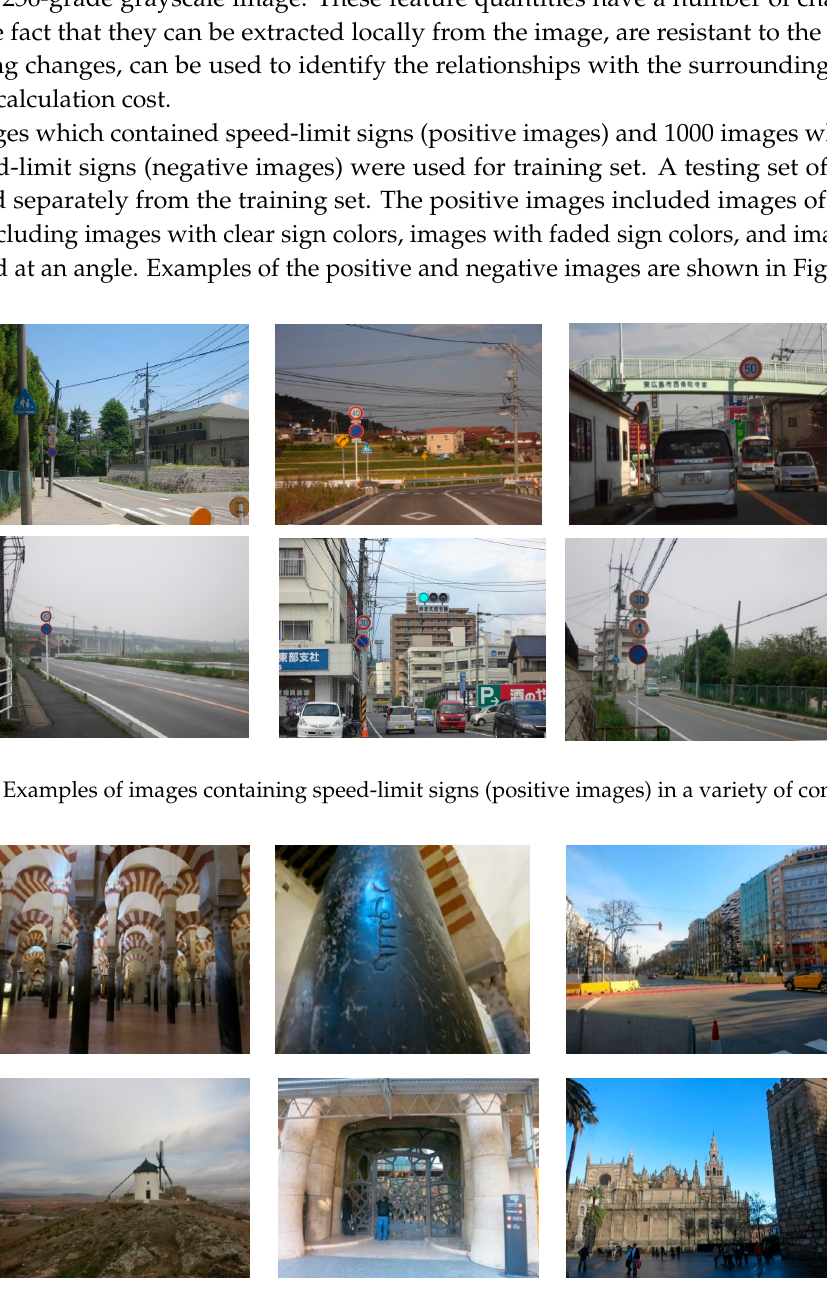
Figure 6. Examples of images not containing speed-limit signs (negative images).